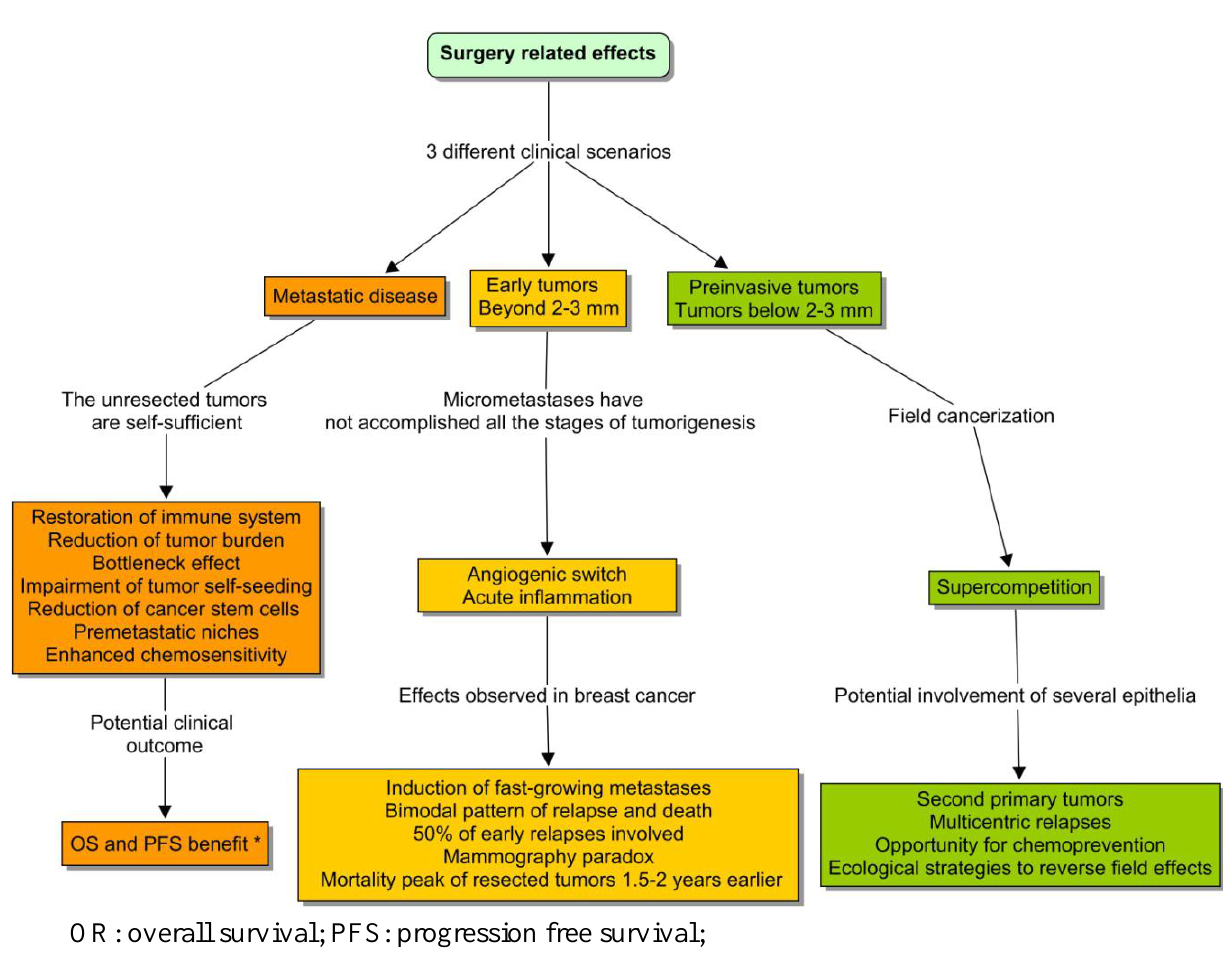
Figure 1. In certain type of tumors, there are three potential outcomes, according to the clinical context. Surprisingly, the work of oncological surgeons argues in favor of “punctuated equilibrium” as a conceptual frame for